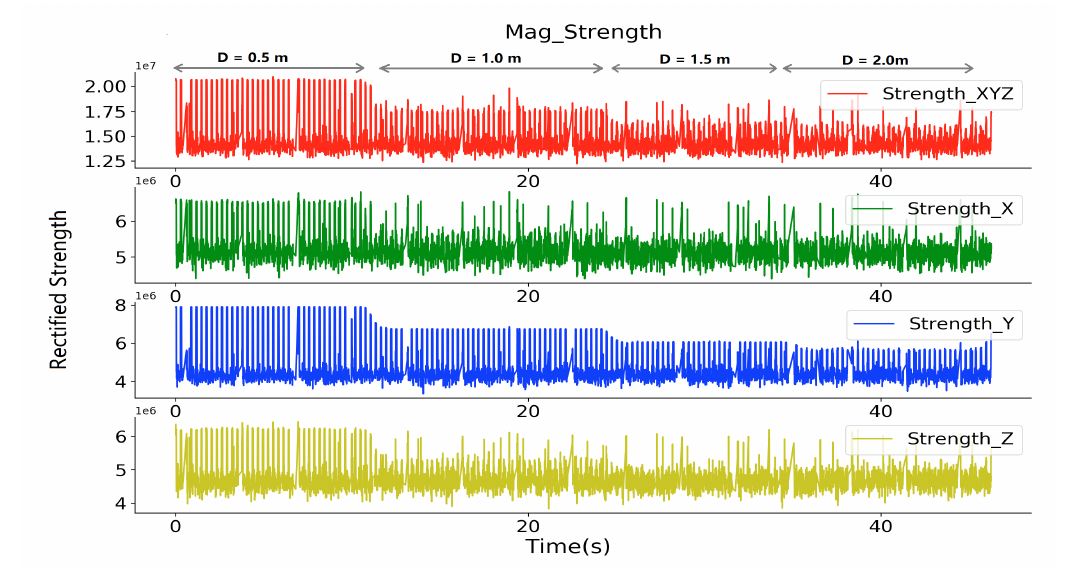
Figure 8. Sampled magnetic field rectified strength in the detection range test with one transmitter